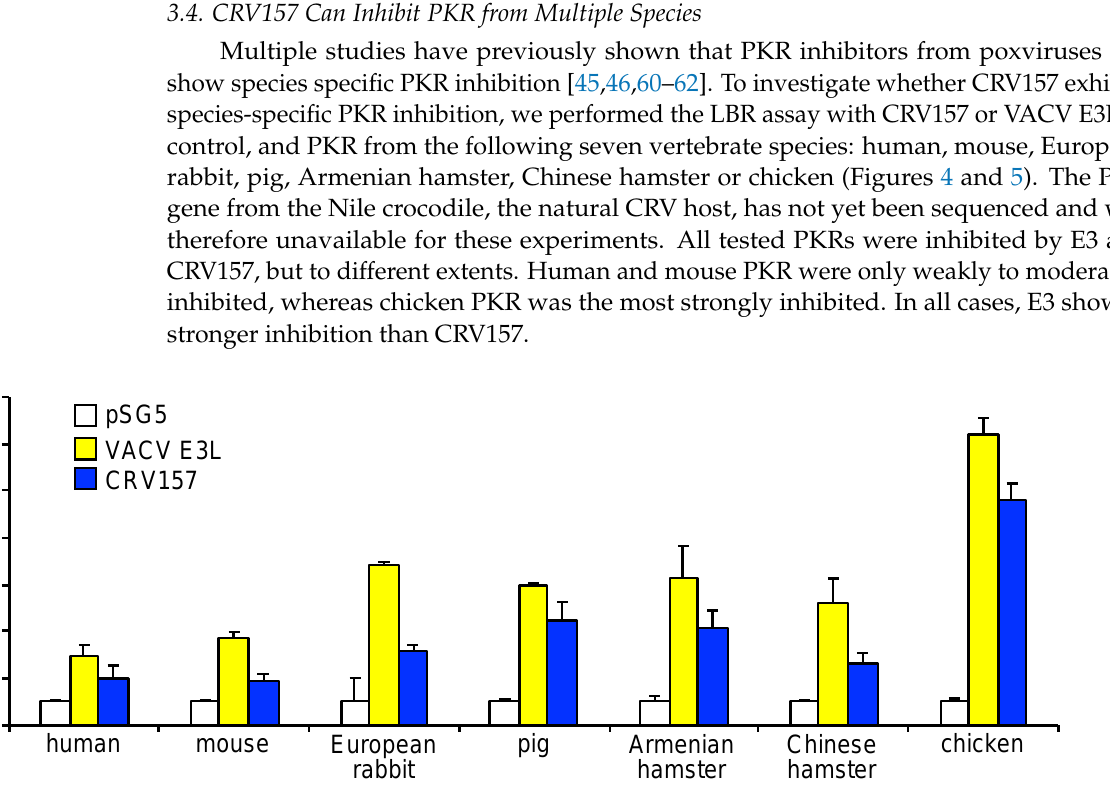
Figure 5. Species-independent PKR inhibition by CRV157. HeLa PKRkd cells were co-transfected with firefly luciferase (0.05 µg) and indicated plasmids encoding mammalian PKRs (0.2 µg) with either CRV157 (0.8 µg) or VACV E3L (0.8 µg) plasmids. For both experiments, standard deviations from three independent transfections are shown. The results shown are representative of three independent experiments.